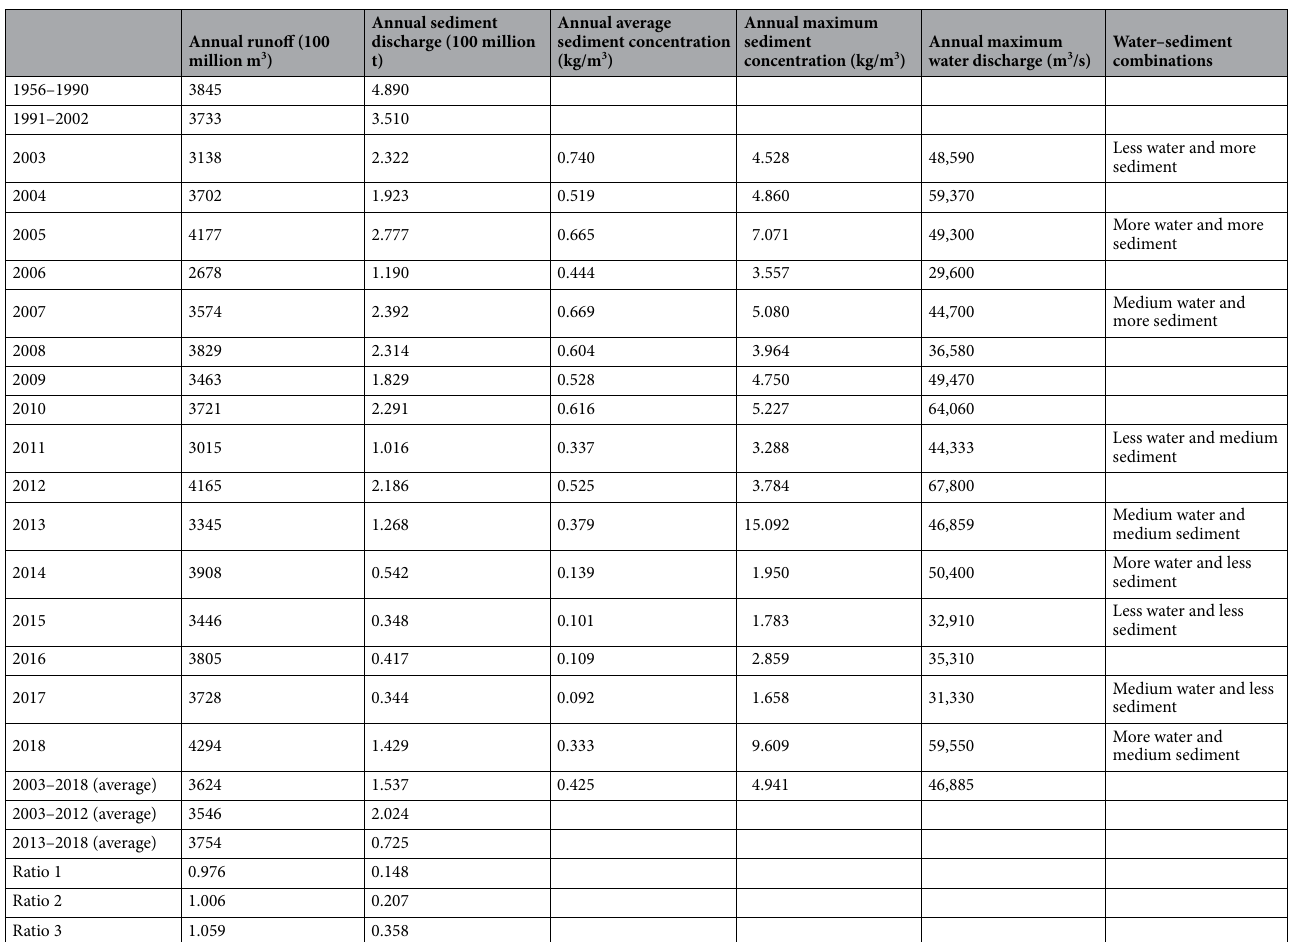
Table 1. Statistical data for the water and sediment characteristics from 2003 to 2018. Ratios 1, 2, and 3 refer to the ratios for 2013–2018 to 1956–1990, 1991–2002, and 2003–2012,